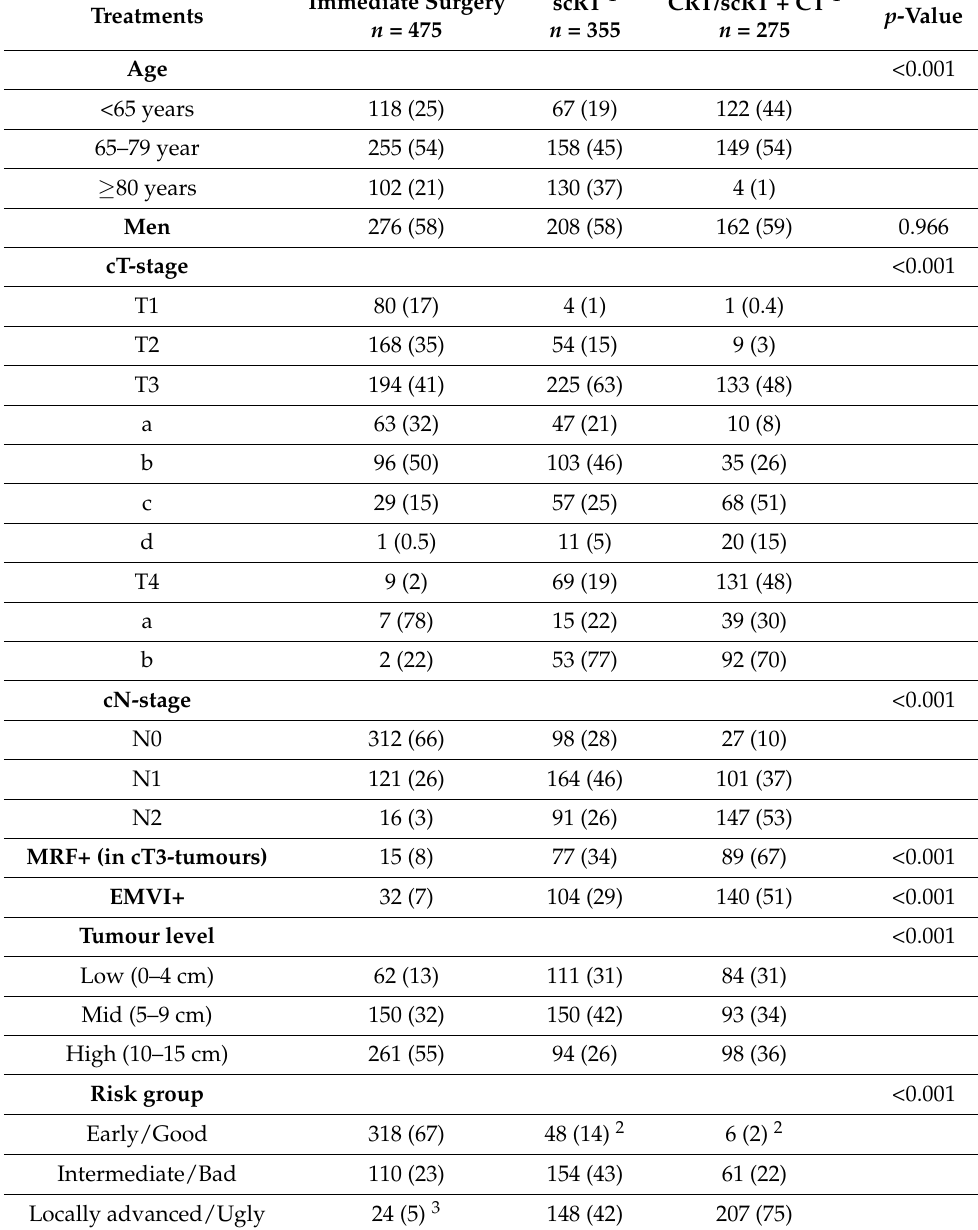
Table 2. Distribution of age, different MRI characteristics, tumour level and risk groups in patients without distant metastases (M0) that had immediate surgery, short-course radiotherapy (scRT) and chemoradiotherapy (CRT)/scRT + chemotherapy